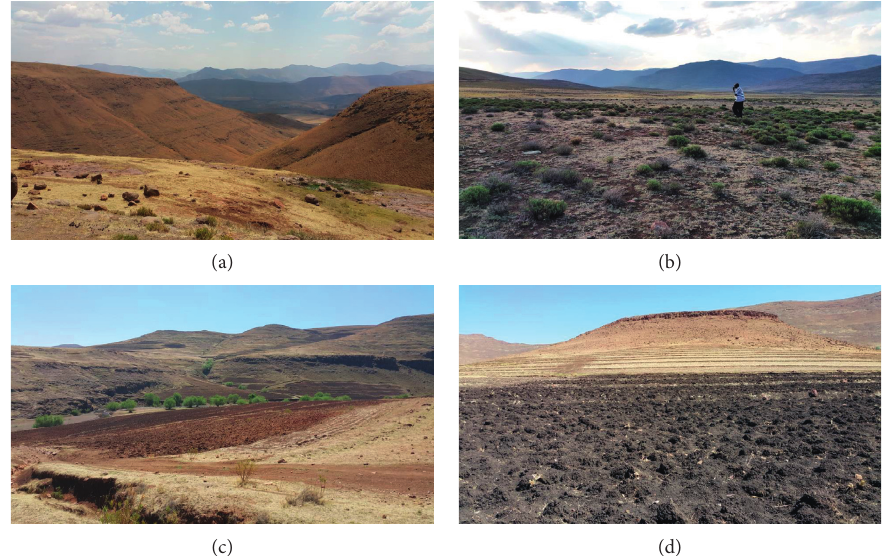
Figure 2: Field photos from eastern Lesotho, showing (a) flat basalt plateau surfaces with deeply incised river valleys, (b) xerophytic and low-nutrient shrubby grassland with a degraded land surface, (c) view of agricultural fields on lower valley slopes; note the presence of trees along river margins and the absence of significant vegetation on upper valley slopes, and (d) terraced fields along lower valley slopes, replaced by grassland on steeper upper slopes. A basalt depositional surface is preserved around the hill